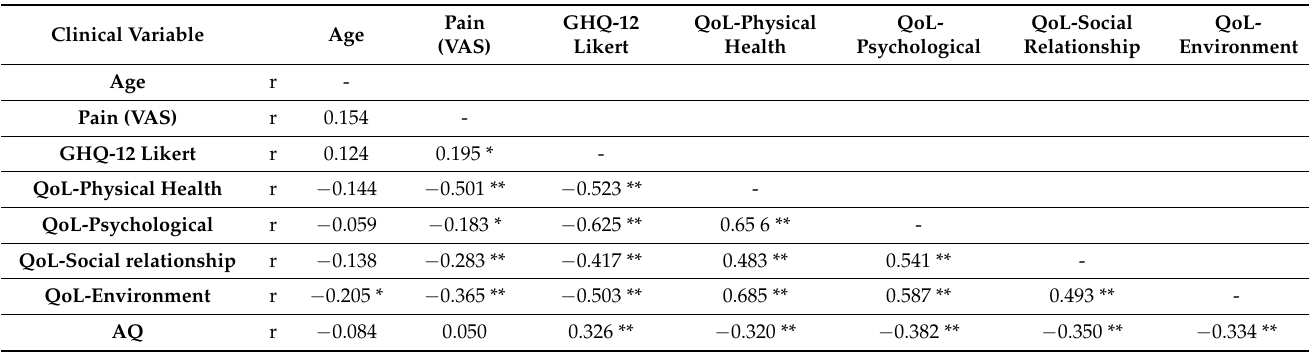
Figure 2. Bonferroni-corrected differences in WHOQOL-BREF domain scores among EDS subtypes. Age was negatively correlated with Environment QoL, with no significant correlation with the other QoL domains, pain, GHQ-12, and AQ. Pain was positively correlated with the GHQ-12 score and negatively correlated with each QoL domain. No correlation emerged between pain and AQ. GHQ-12 was negatively correlated with each QoL domain and positively correlated with AQ. AQ was negatively correlated with each QoL domain (see Table 2). Table 2. Pearson’s correlation